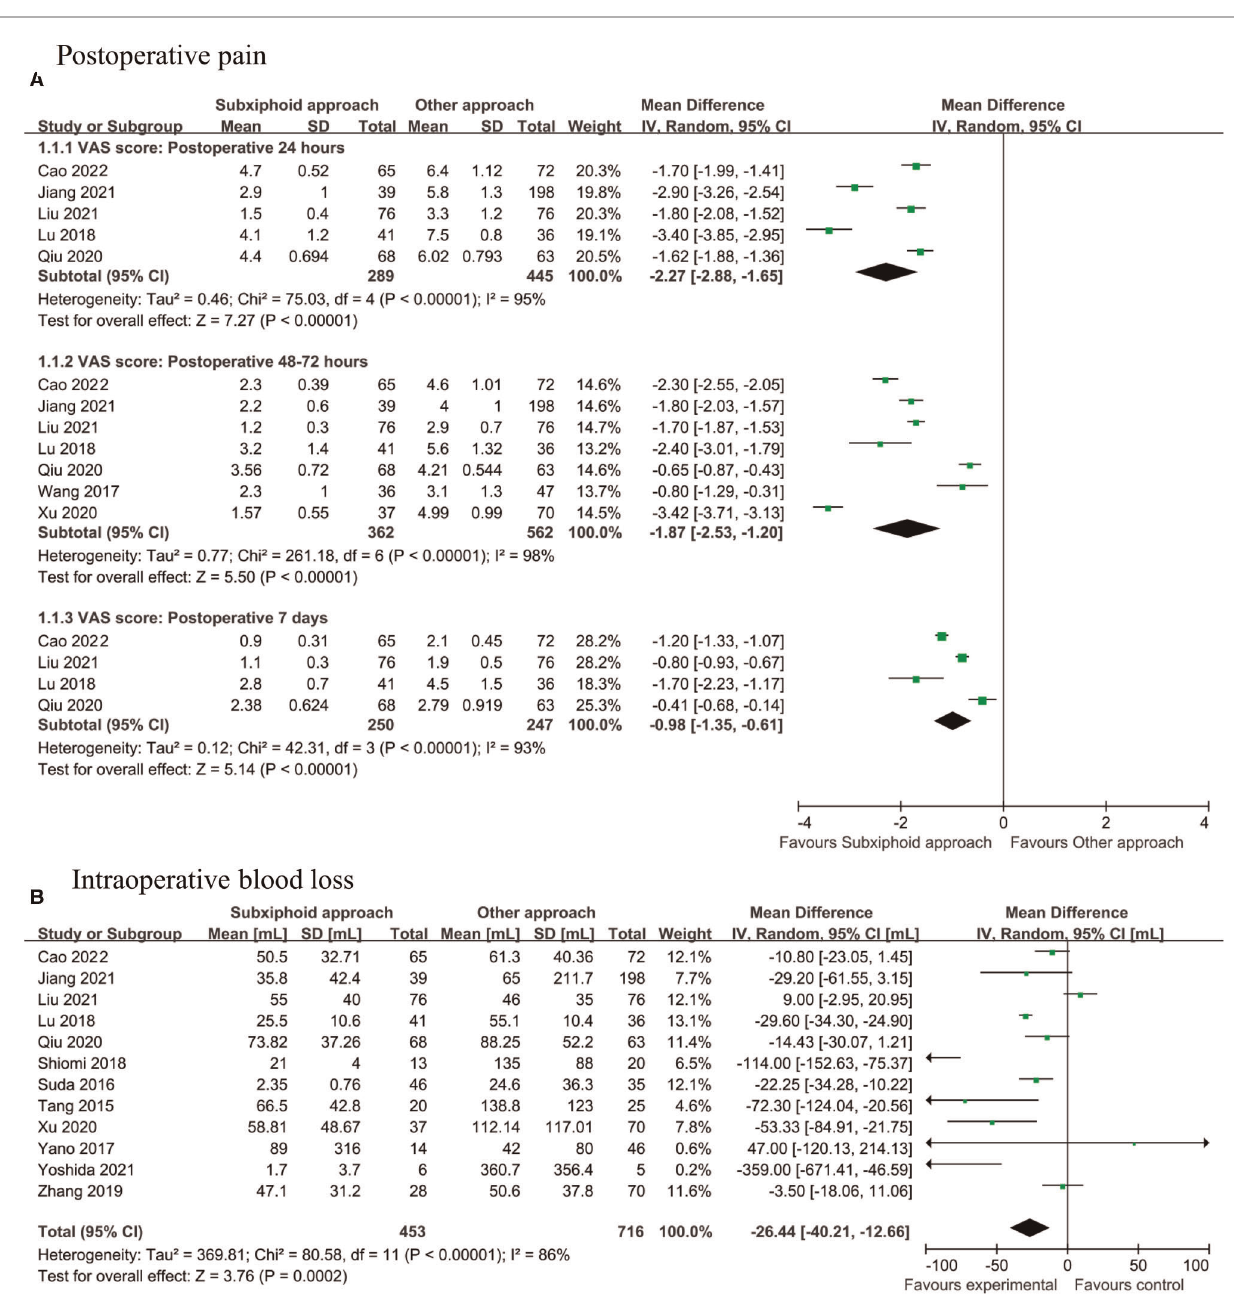
FIGURE 2 | Pooled estimates of included studies evaluating the effect of subxiphoid approach on ( A ) postoperative pain and ( B ) intraoperative blood